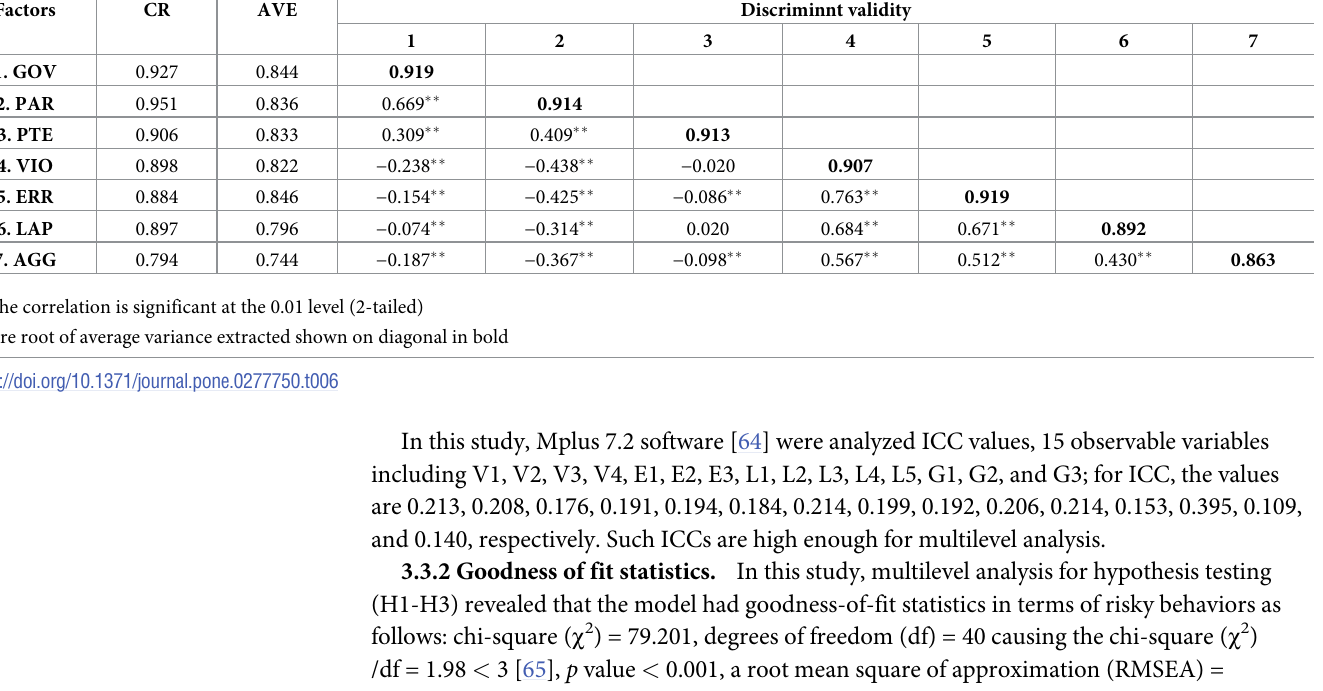
Table 6. Discriminnt validity, composite reliability (CR), and average variance extracted (AVE). Factors CR